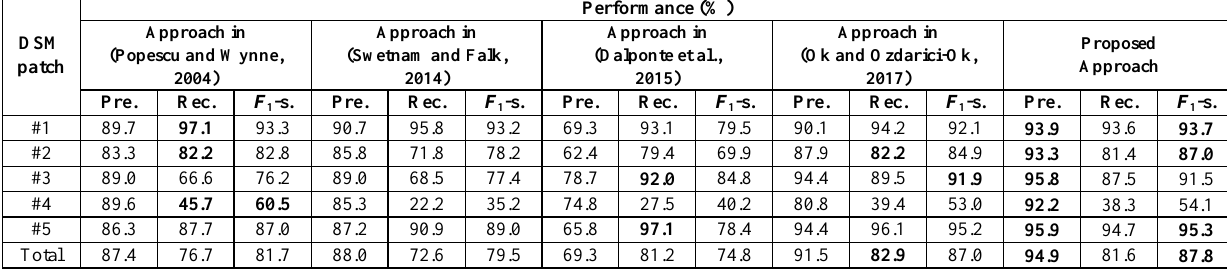
Table 4. Comparison of the results of the state-of-the-art and the proposed approach. Pre., Rec., and F 1 -s. denote Precision, Recall and F 1 -score,